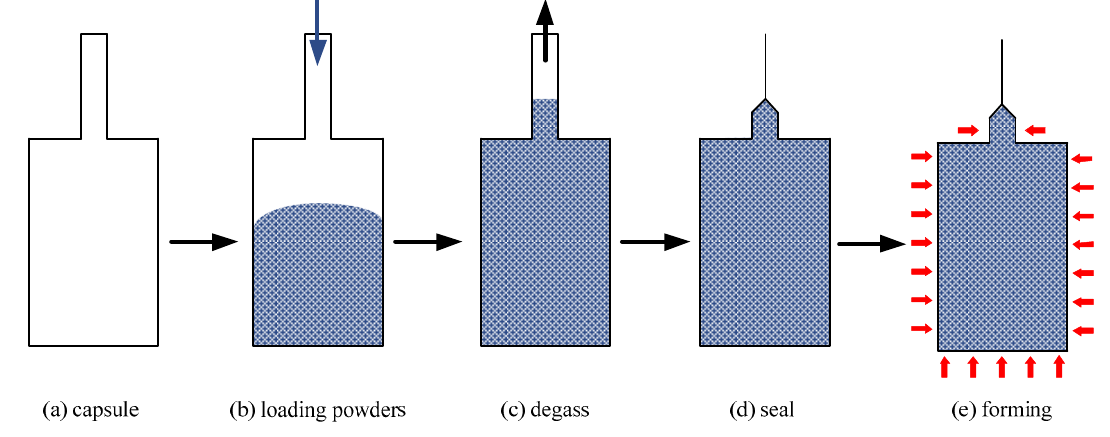
Figure 3. Schematic of HIP process.